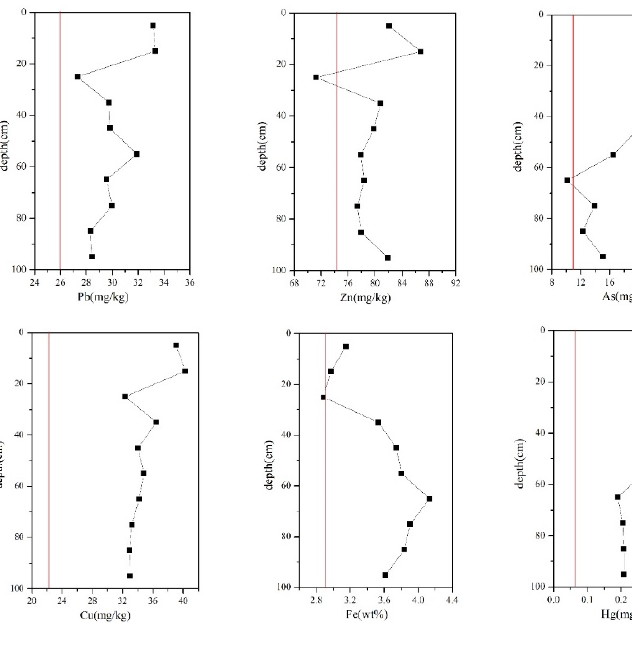
Figure 8. Distribution of metal concentrations in vertical profile soils under the tailings. The red line indicates background value.